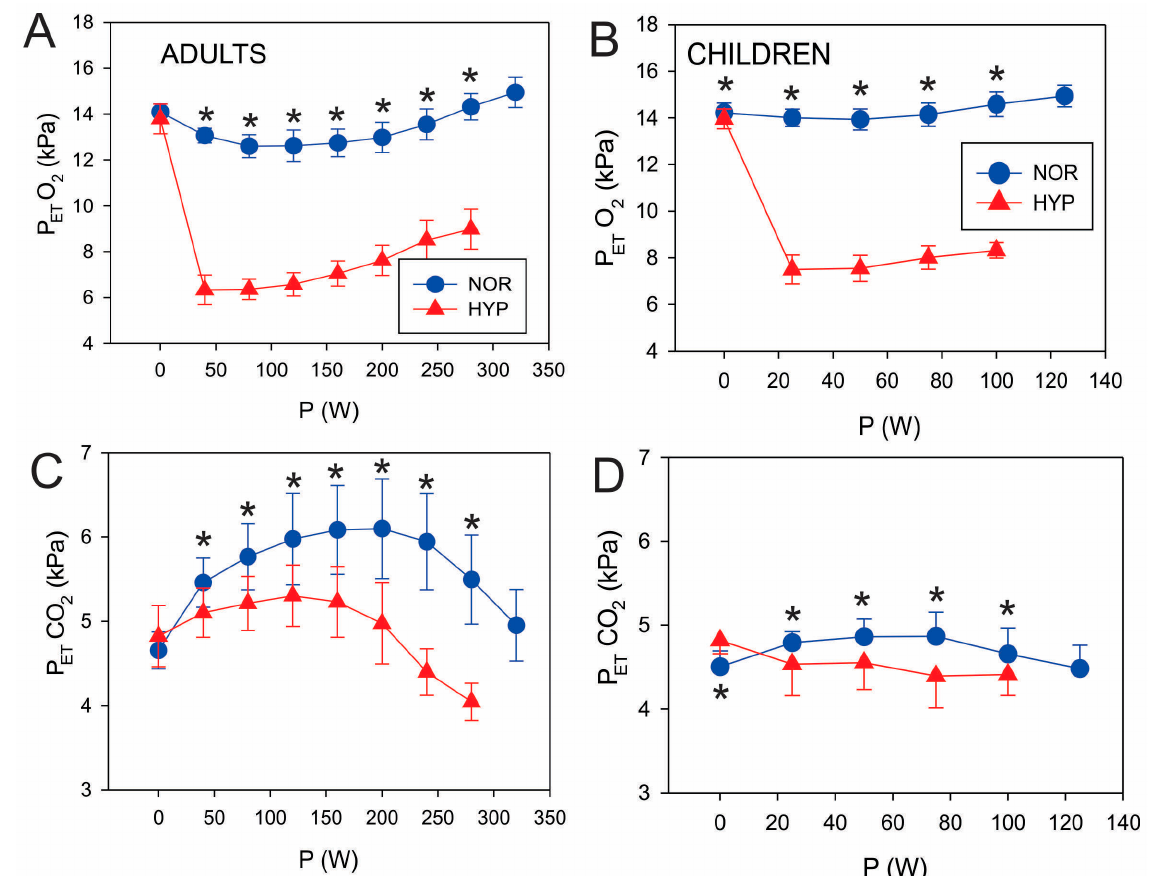
Figure 2. Resting and exercising values of end-tidal oxygen pressure (P ET O 2; panels ( A , B )) and end-tidal carbon dioxide pressure (P ET CO 2 ; panels ( C , D )) for both adults and children. Values are reported as means (SD). Significant post hoc differences: * ( p < 0.05) denotes significantly different values compared to NOR.